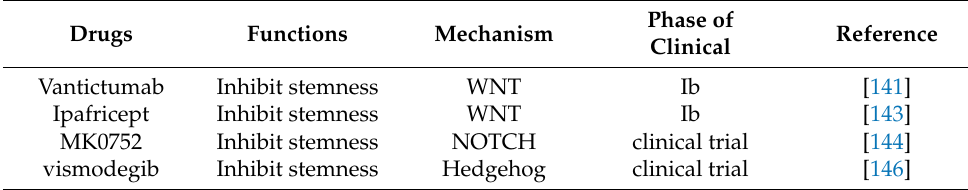
Table 5. Current therapies targeting